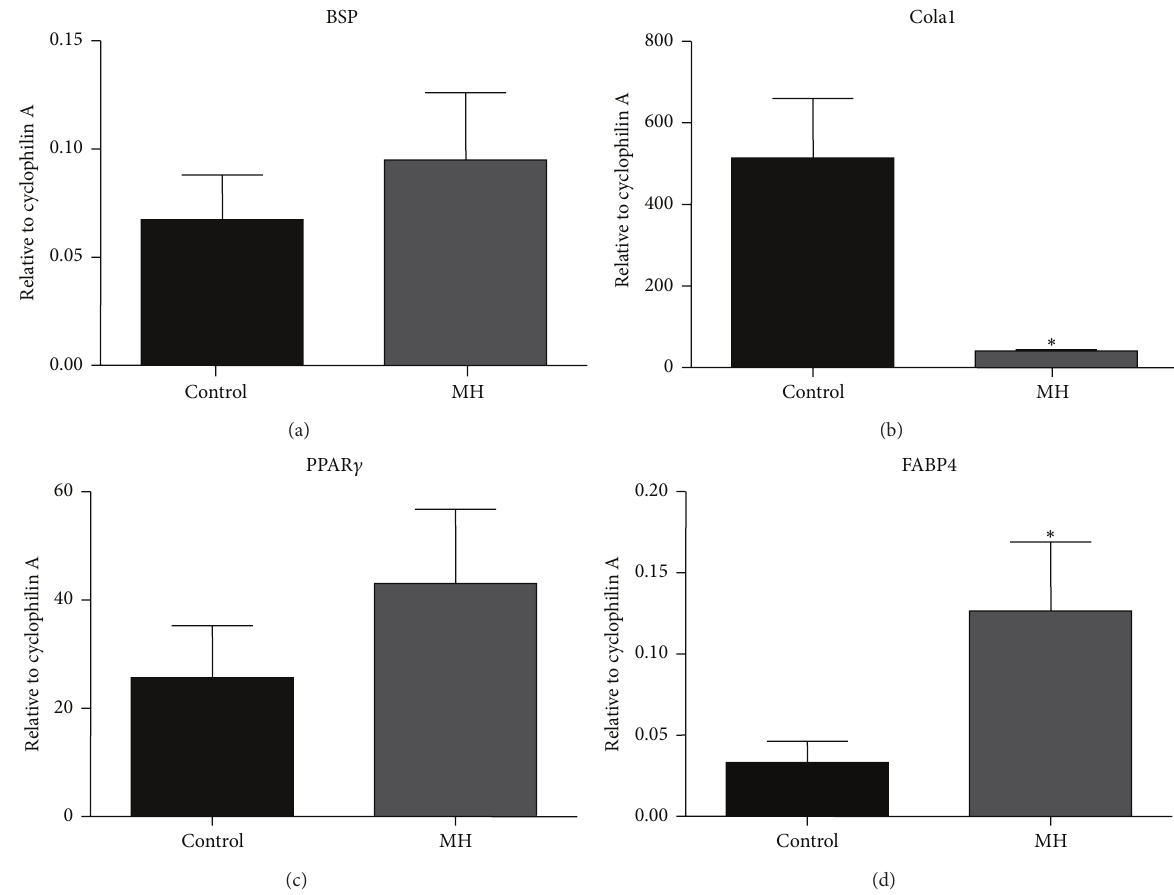
Figure 6: Effects of MH on mRNA expression of genes in the metaphysis bone of postnatal offspring. Quantitative real-time RT-PCR expression data for BSP (a), Cola1 (b), PPAR 𝛾 (c), and FABP4 ((d), 𝑃 = 0.05 ) are expressed relative to internal standard cyclophilin A. ∗ 𝑃 < 0.05 when compared to control ( 𝑛 = 5 ).